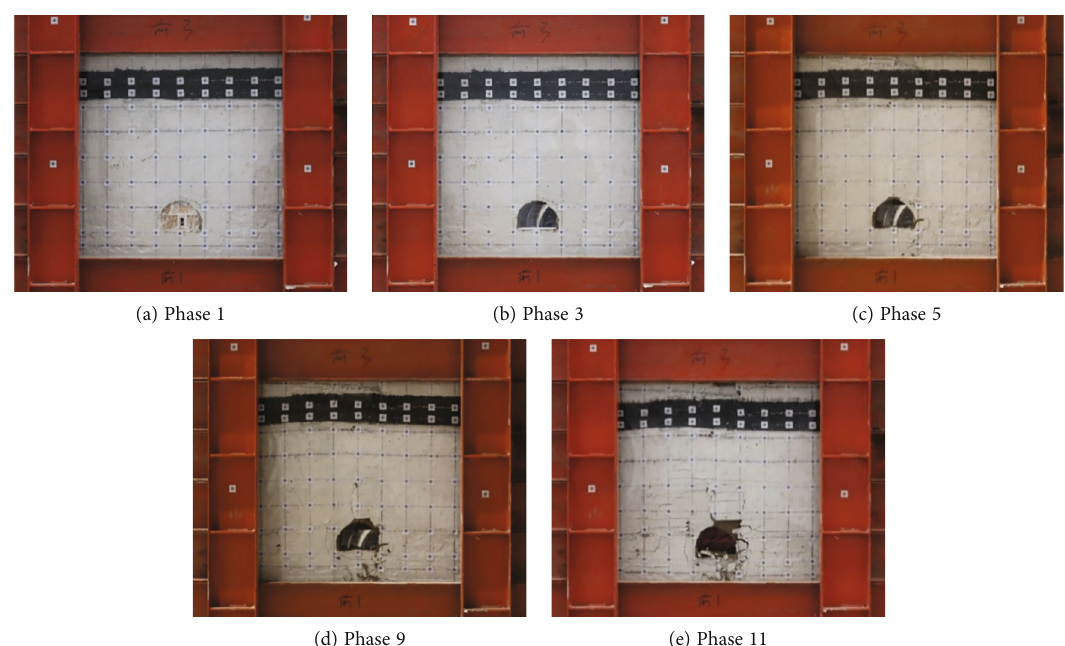
Figure 9: Fracture development characteristics on the roadway surface in di ff erent loading